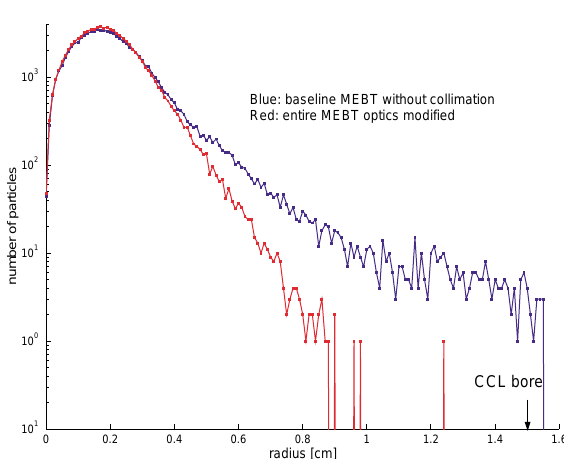
FIG. 7. (Color) Radial particle distributions at CCL (171 MeV point) before (top curve) and after reducing the beam eccentricity (bottom curve). After modification, halo is reduced significantly.